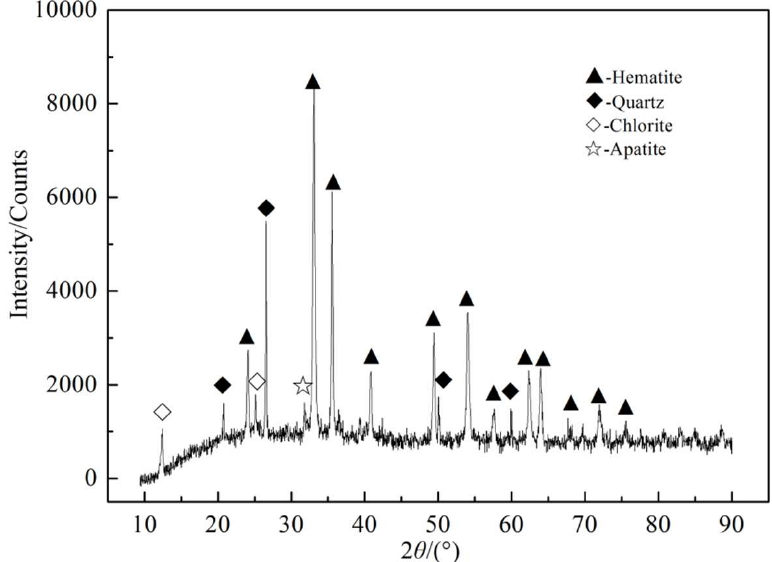
Figure 2. XRD spectrum of raw ore.